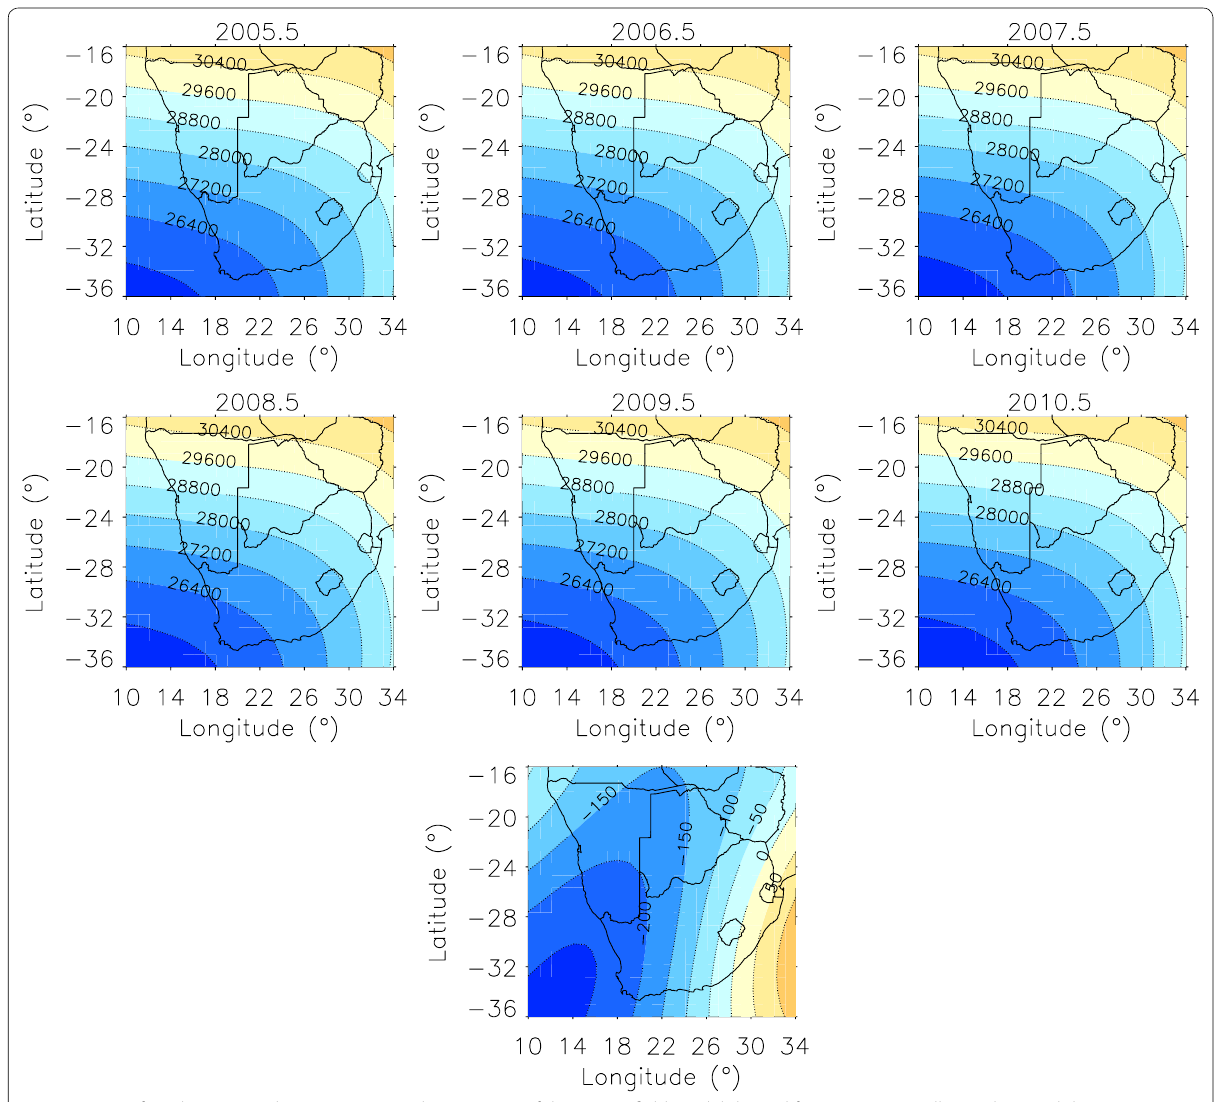
Fig. 9 Maps of total intensity F between 2005 and 2010. Maps of the F main field model derived from CHAMP satellite and ground data at six selected epochs between 2005 and 2010 (first two rows) and the change of the field between 2005.5 and 2010.5 epochs (last row) at 0.8 km